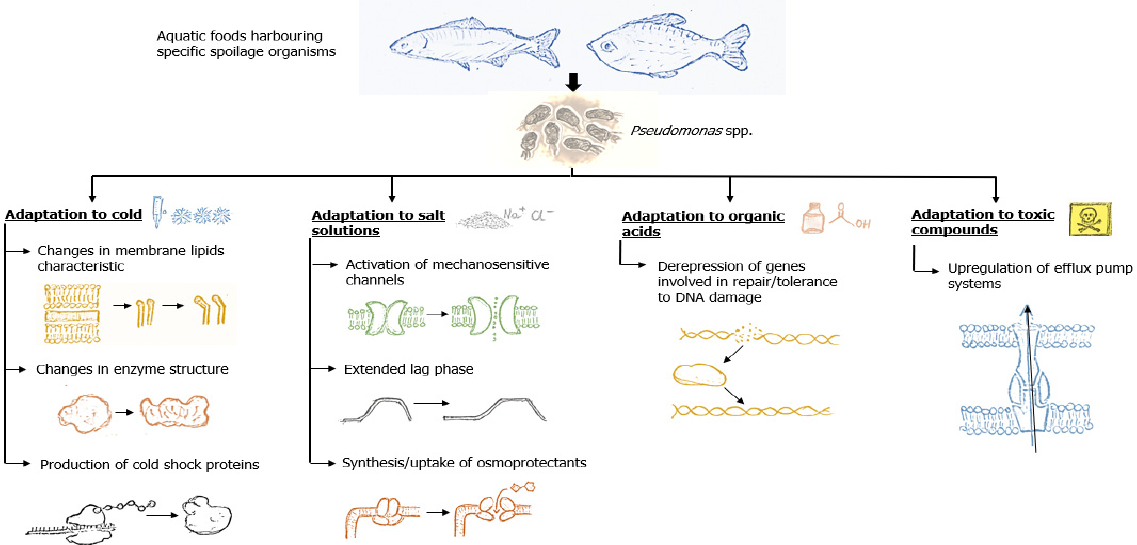
Figure 1. Schematic explanation of Pseudomonas spp. adaptation strategies to environmental con ‐ ditions.